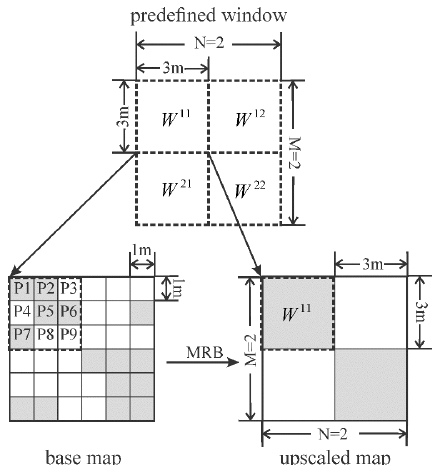
Figure 2. A general scheme for implementation of similarity matrix. Class 1 is gray and Class 2 is white. Table 3. Similarity matrix for the example in Figure 2. OS, OE, and CE represent overall similarity, omission error, and commission error, respectively.